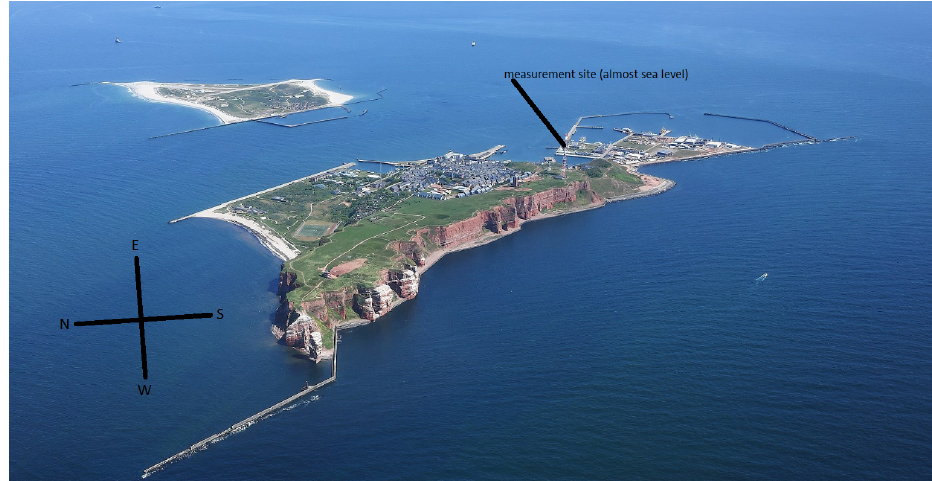
Figure 2. Heligoland